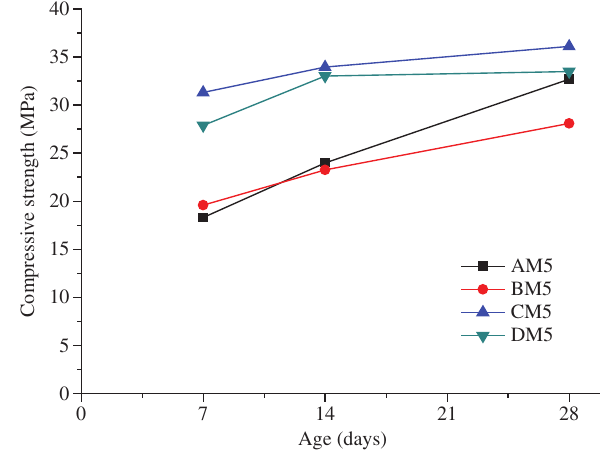
Figure 2: Compressive strength development of AAFA geopolymer with the alkaline solution/binder ratio of 0.5 vs. age.